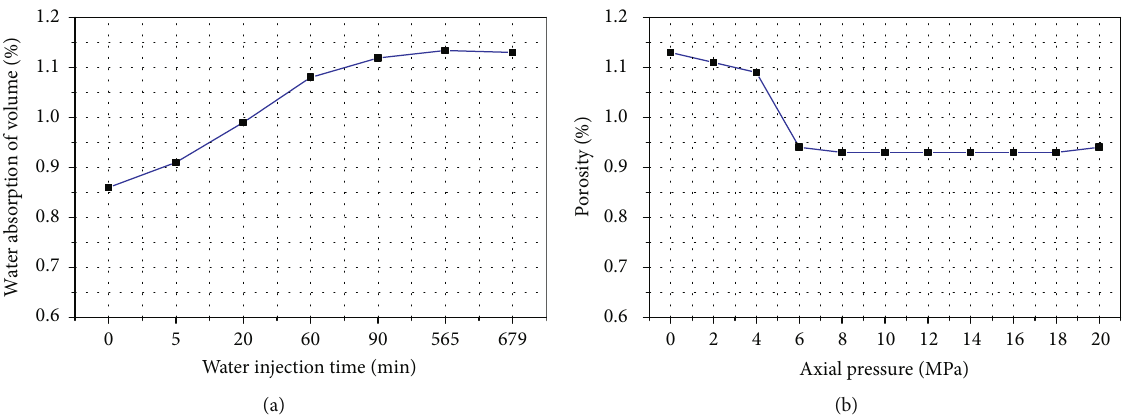
Figure 10: The changes of the water content and porosity. (a) Water content during water injection. (b) Porosity during the compression process.